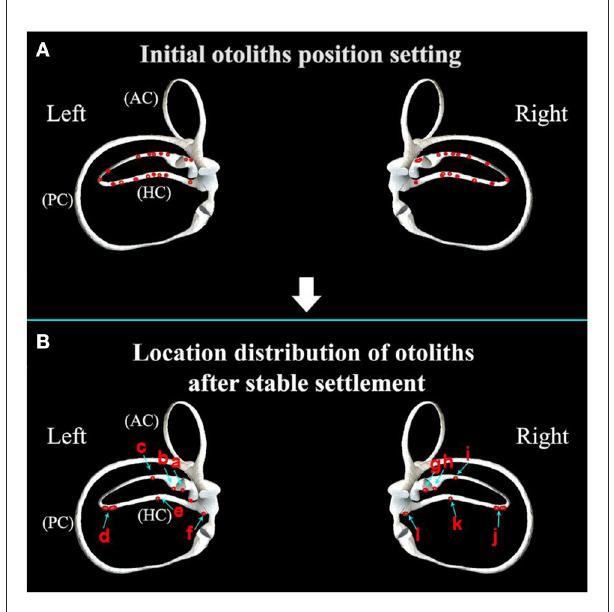
FIGURE3 (A) Initial otoliths position setting in the horizontal semicircular canal; (B) location distribution of otoliths after stable settlement. (a) The side of the short arm (the ampulla near the utricle); (b) the ampulla of the long arm; (c) the anterior arm of the long arm; (d) the posterior arm of the long arm; (e) the posterior arm is close to the opening of the utricle; (f) utricle opening of the posterior arm.